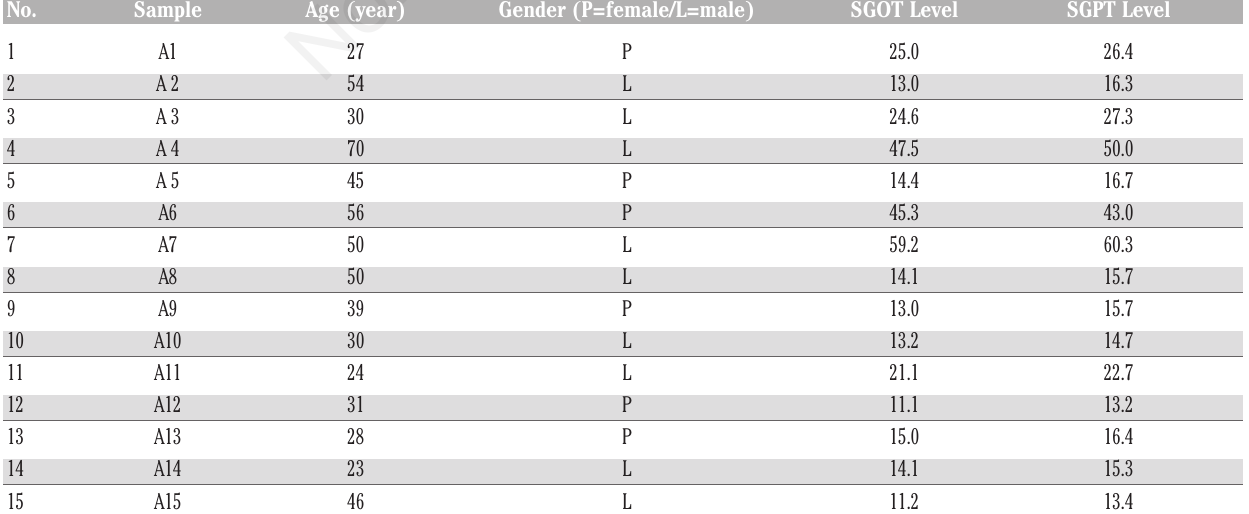
Table 1. The Result of SGOT and SGPT Levels in TB Patients who are undergoing OAT treatment in Kendari City General Hospital Kota Kendari